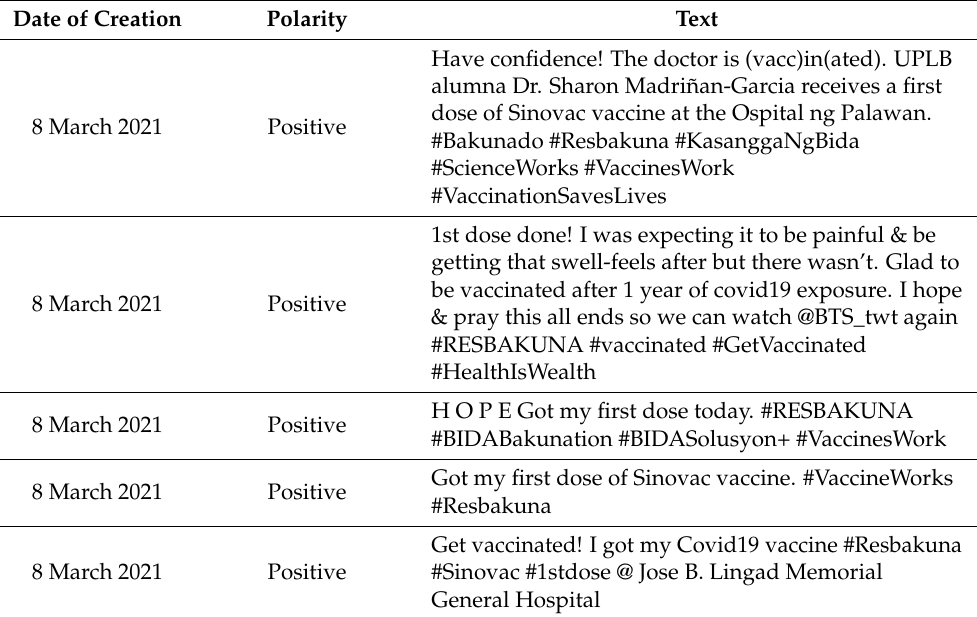
Table 3. These are some of the collected tweets imported as an example set in the RM application. Displayed attributes are date of creation, polarity, and the text of the